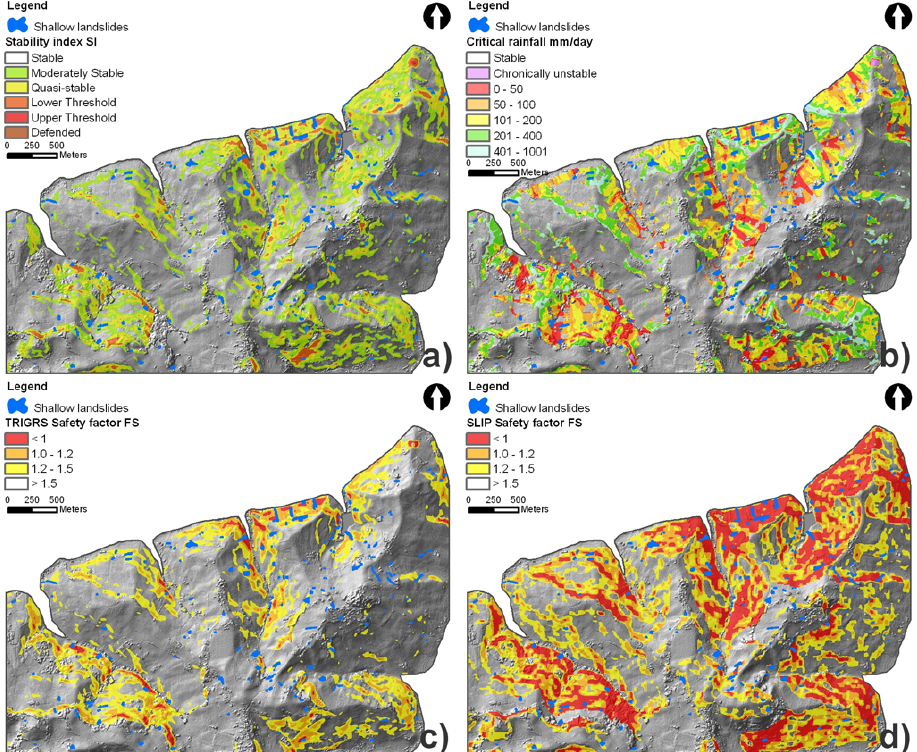
Fig. 7. Landslide susceptibility map of area 2: (a) Stability index map obtained by SINMAP; (b) Critical intensity of rainfall (mmday − 1 ) computed by SHALSTAB; (c) Safety factor map obtained using TRIGRS; and (d) Safety factor map obtained using SLIP.